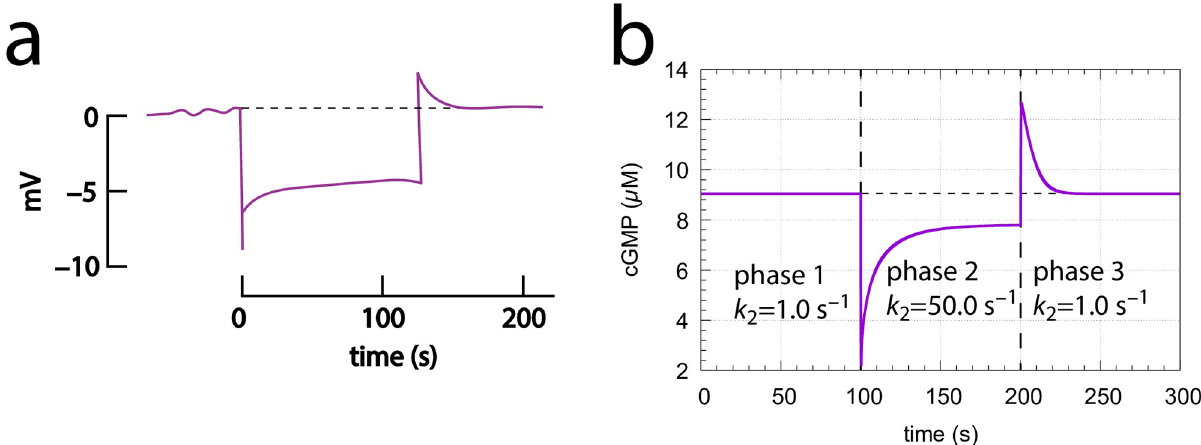
Fig 17. Experimental and model behaviors when applying step perturbations. (a) Experimental response of a red-sensitive turtle cone to a long step of light. Redrawn from Ref [53] (Fig 14, trace 2). (b) Model calculation using a k 21 ! 50 s − 1 step at time t =100s. After 100 s k 2 returned to its original value. Background k 4 =0.0 s − 1 . All other rate parameters are as described in section “Estimation of model parameters”. Initial concentrations: cGMP = 9.04 μ M, Ca 2 þ ¼ 125 : 7 nM , K + =2.0 μ M. See also S1 Programs in S1 File. i